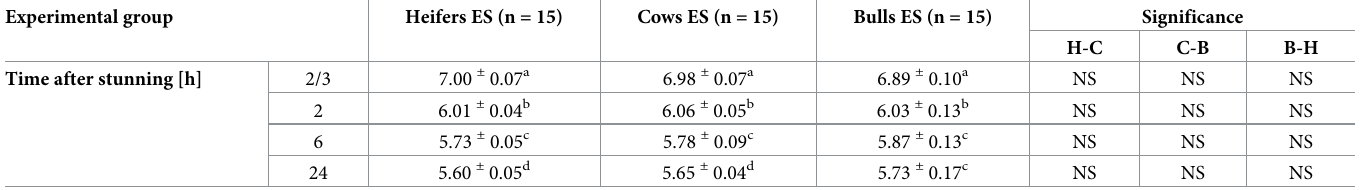
Table 3. Changes in the pH value ( � x ± SD) of the longissimus dorsi muscle of electrostimulated (ES) heifers (H), cows (C), and bulls (B) chilled with the accelerated method � . Experimental group Time after stunning